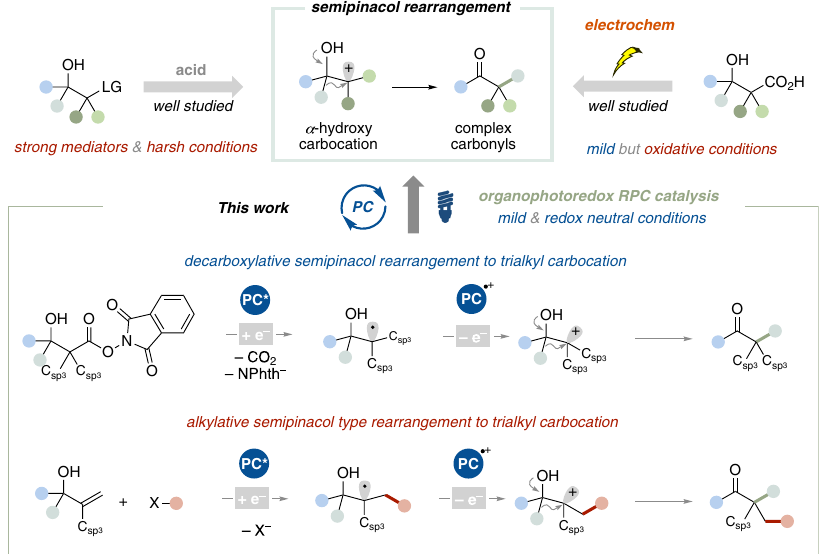
Fig. 1 Overview of semipinacol rearrangement. Comparison with previous works such as ionic approach or electrochemical approach and this work based on organophotoredox